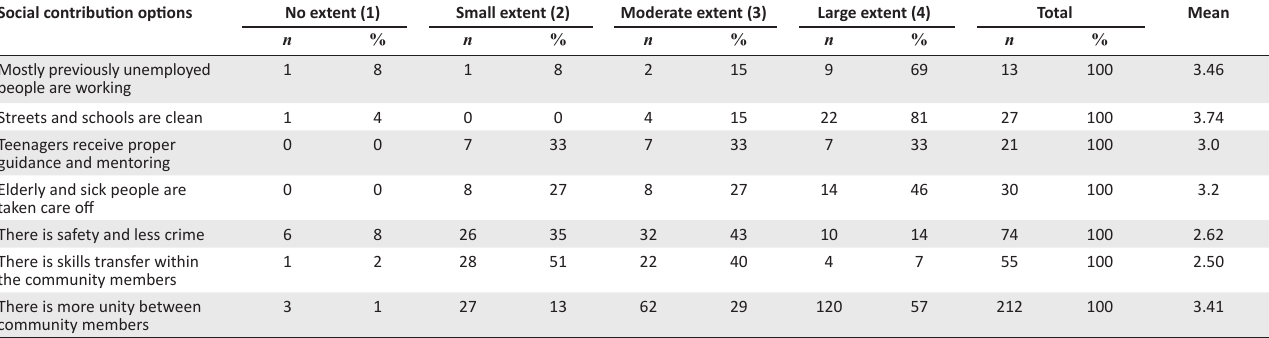
TABLE 5: Respondents’ perception of the extent to which community work programme develops Erasmus and Soshanguve. Social contribution options